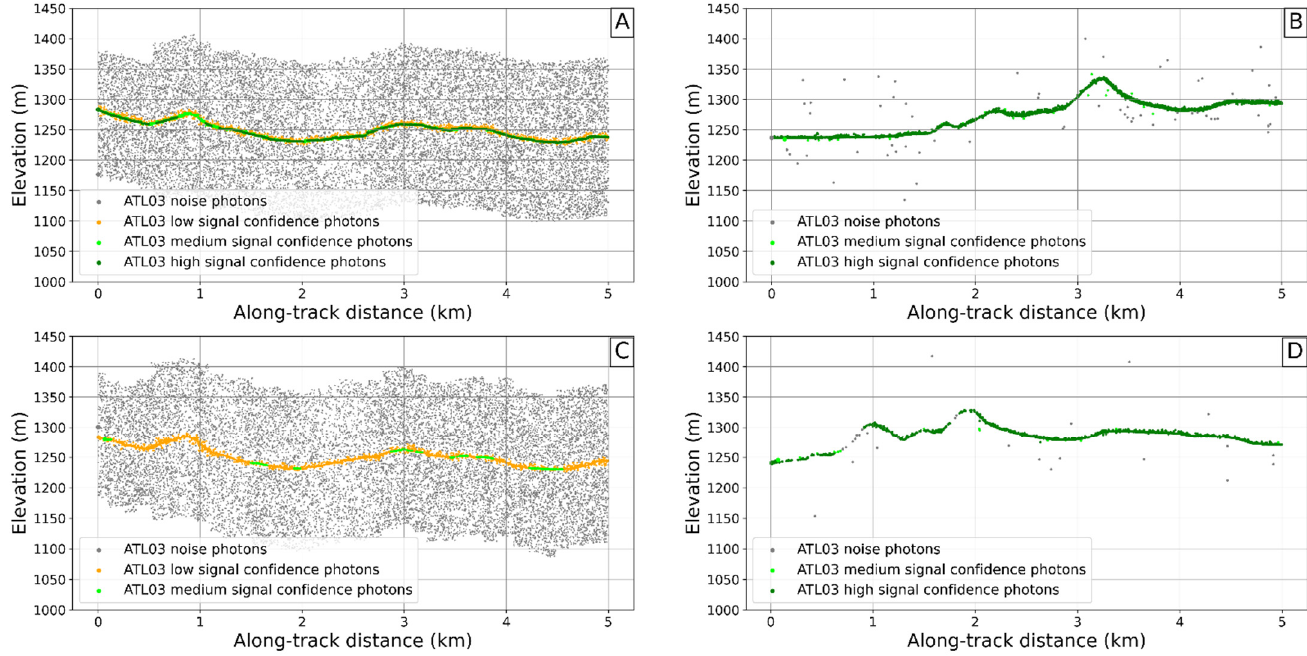
Figure 7. Signal photons extraction using the signal confidence flag for ( A ) strong beam during day-time acquisition, ( B ) strong beam during night-time acquisition, ( C ) weak beam during day-time acquisition, and ( D ) weak beam during night-time acquisition.